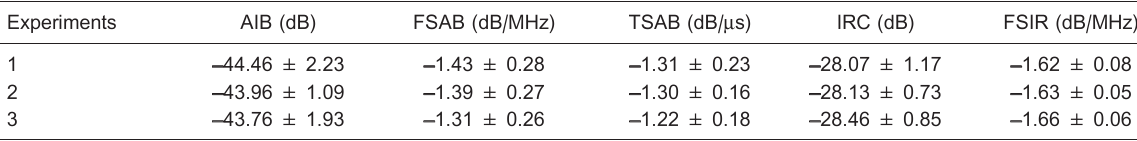
Table 1. Average values and standard deviation of each parameter in three experiments.